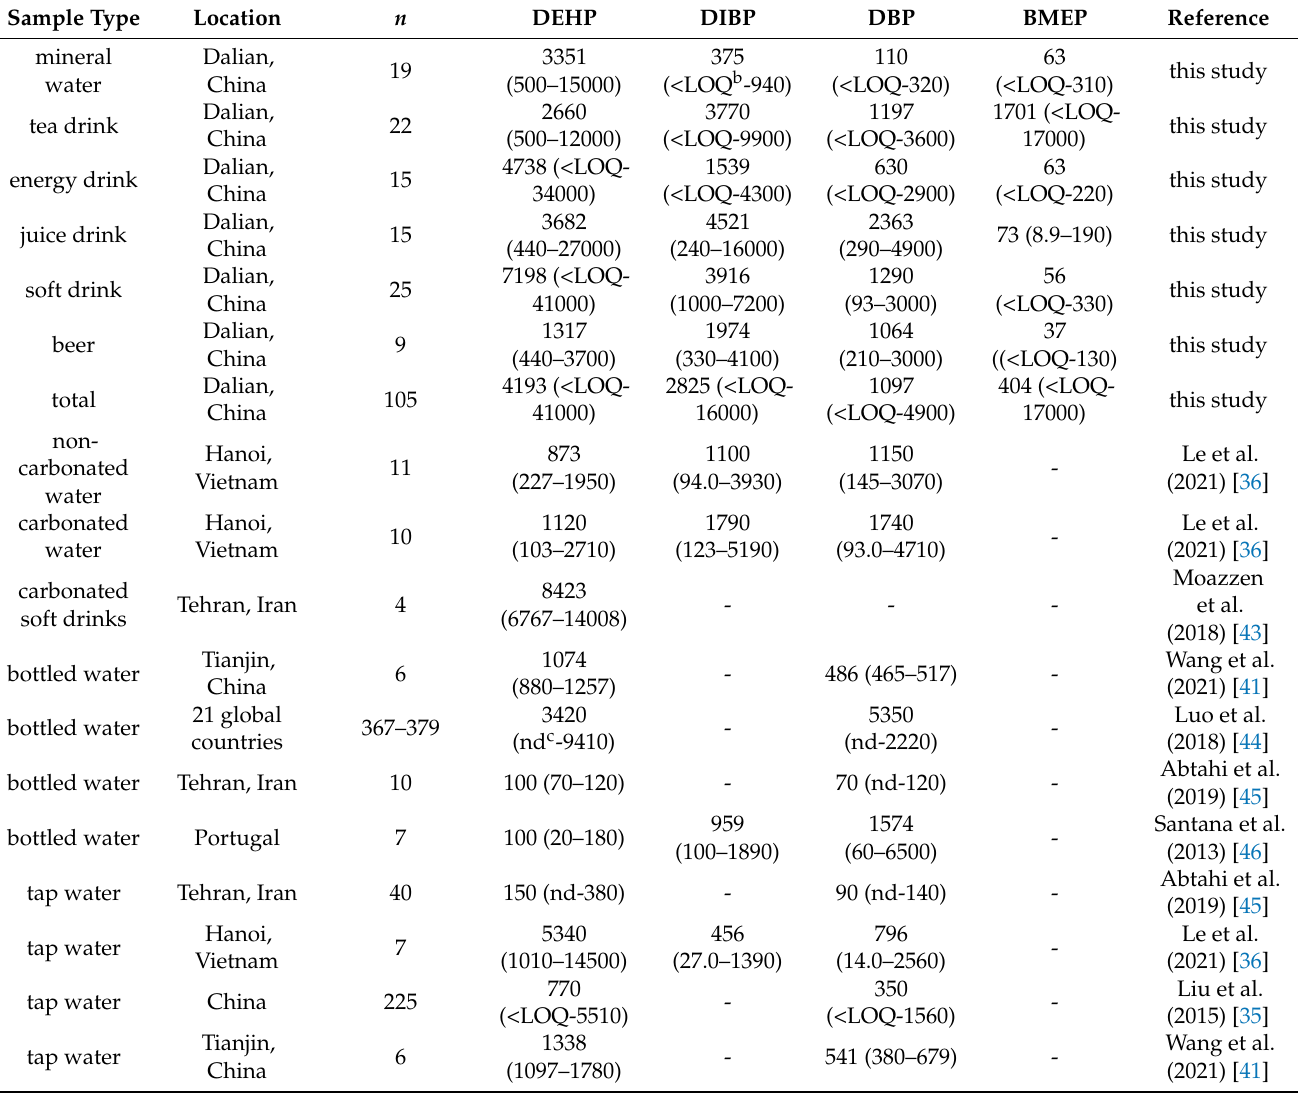
Table 2. Concentration a (ng/L) comparison of DEHP, DIBP, DBP, and BMEP in bottled drink, bottled water, and tap water samples from various